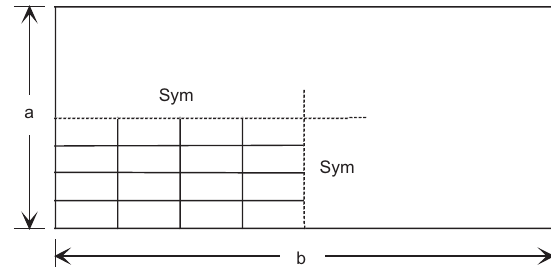
Figure 3 Simply supported and clamped rectangular plate.